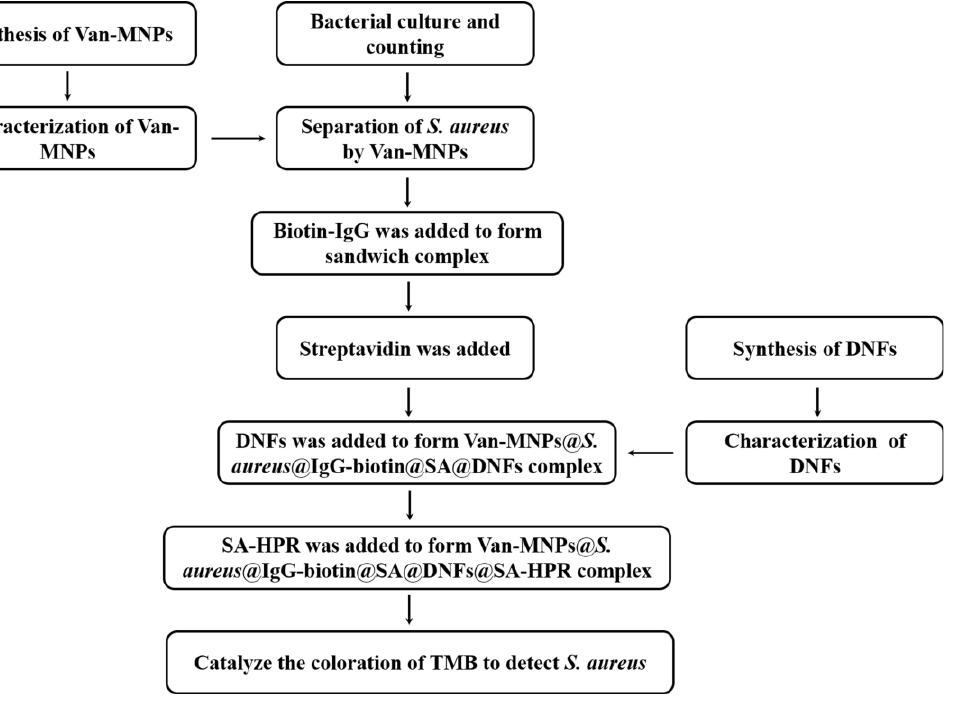
Figure 1. Flow chart of experimental steps.